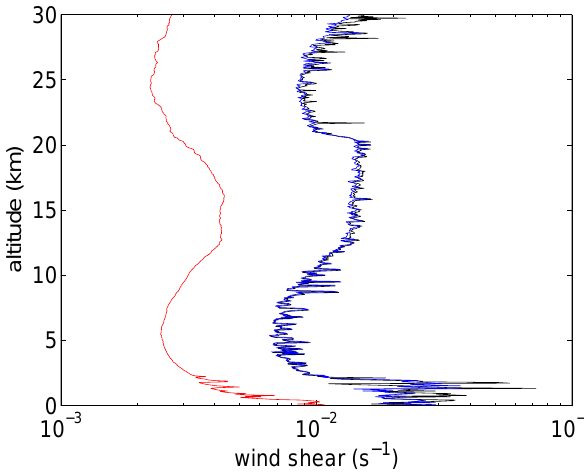
Fig. 15. Zonal wind-shear standard deviation (s − 1 ) for model winds (red curve), radiosonde winds (blue) and adapted model winds (black). The radiosonde wind and adapted model wind profiles largely